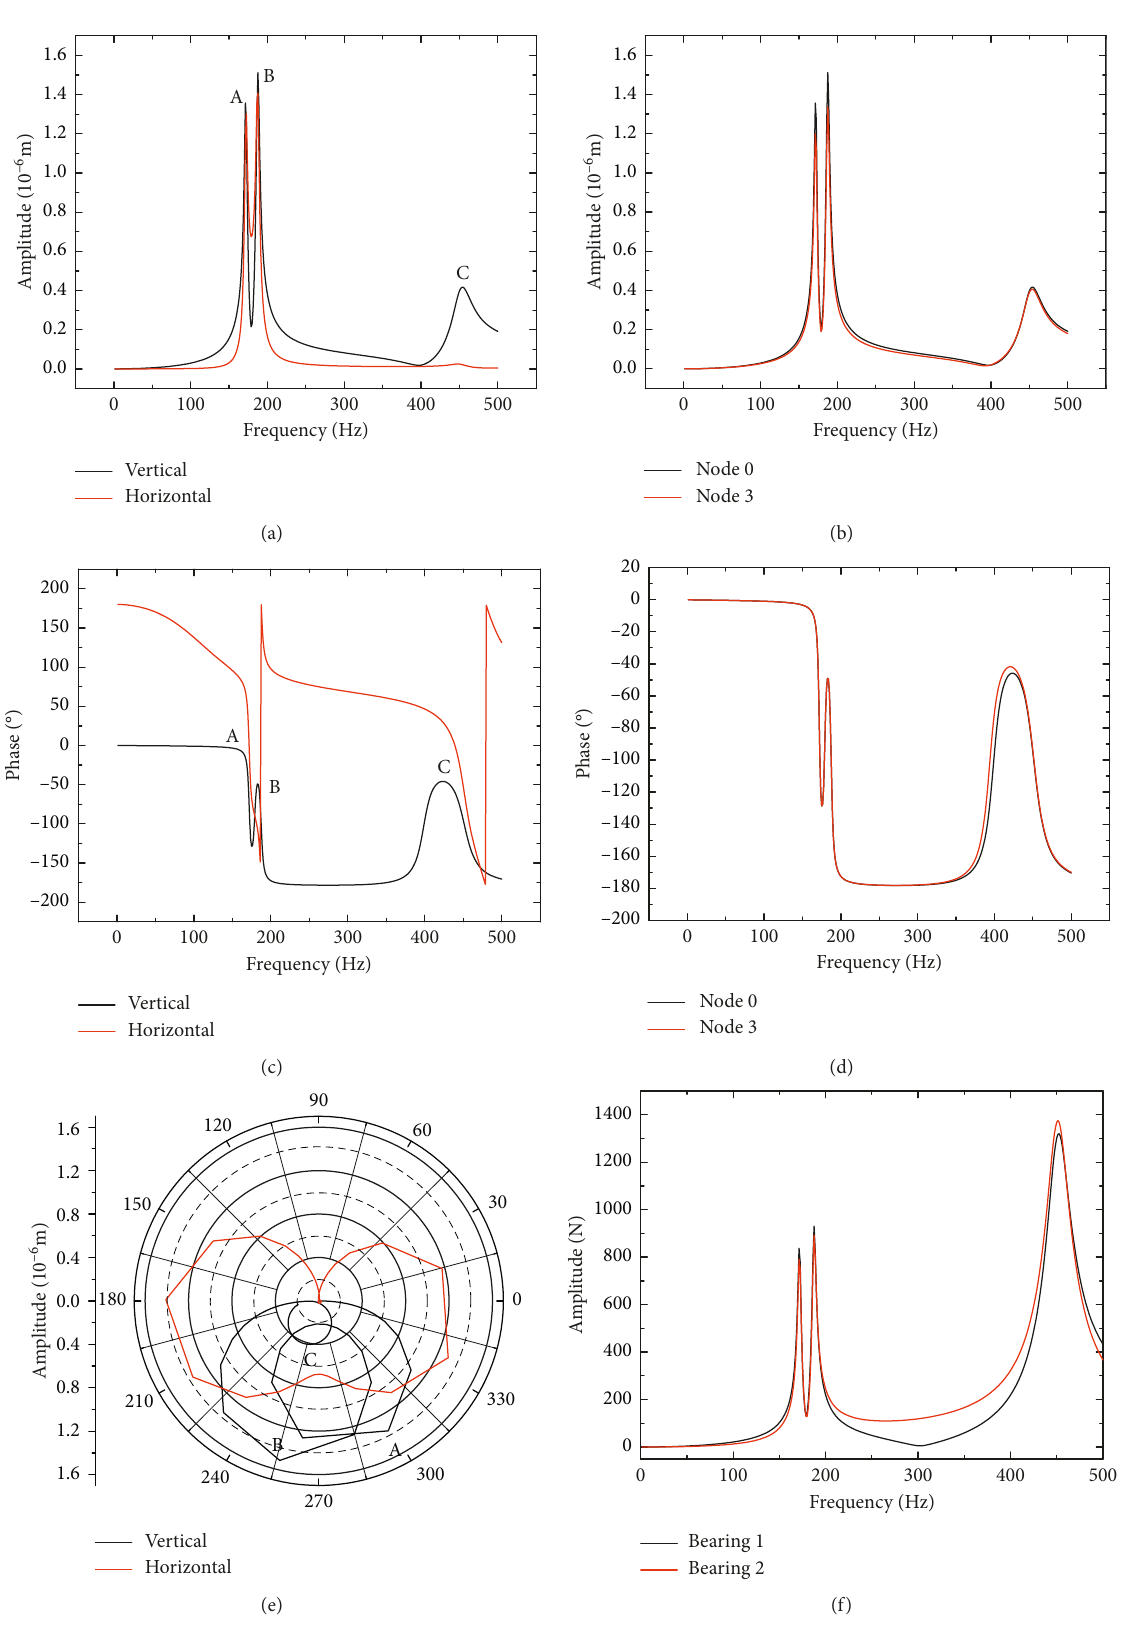
Figure 14: Rotor response and support reaction characteristics for condition 4 (isotropic bearing stiffness). (a) Amplitude response at node 0. (b) Amplitude response for vertical direction. (c) Phase response for at node 0. (d) Phase response for vertical direction. (e) Polar diagram for horizontal direction at node 0. (f) Support reaction at vertical